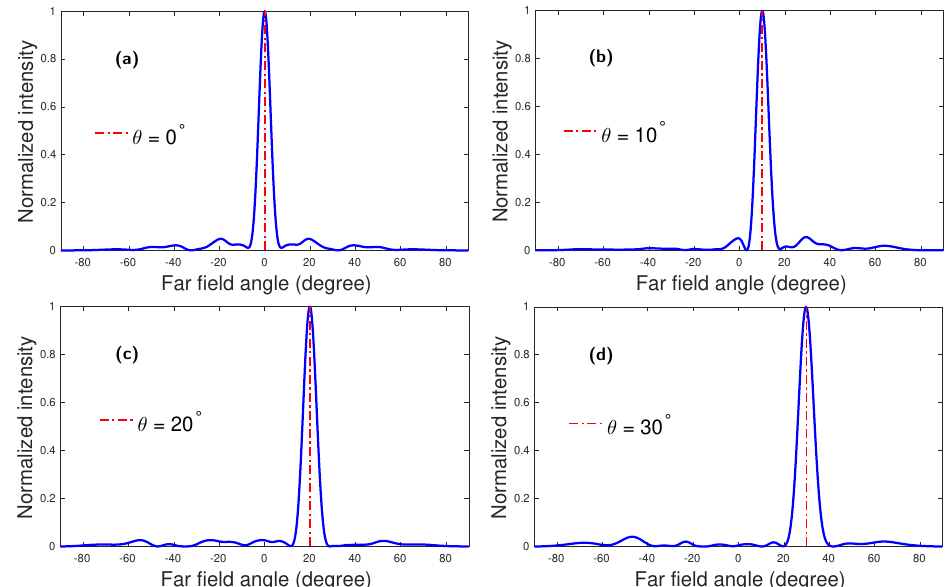
Figure 4. Far-field angular spectrum for optimum single-beaming effects. The beaming angles are ( a ) θ = 0 ◦ , ( b ) θ = 10 ◦ , ( c ) θ = 20 ◦ , and ( d ) θ = 30 ◦